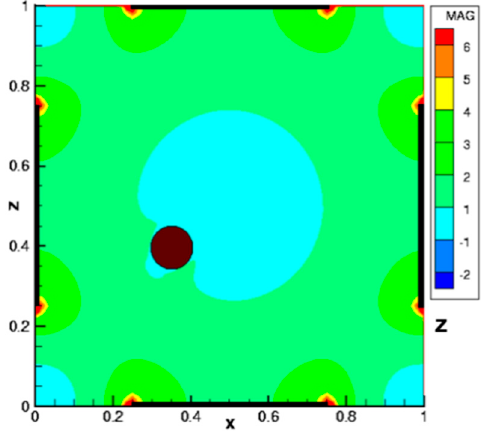
Figure 8. Isovalues of log| E| at the domain mid-plane, y = 0.25, with a particle present (a = 0.05 and ε p = 1.5). The dimensionless parameters are: Re = 0.113, P E = 3080, and P 4 =